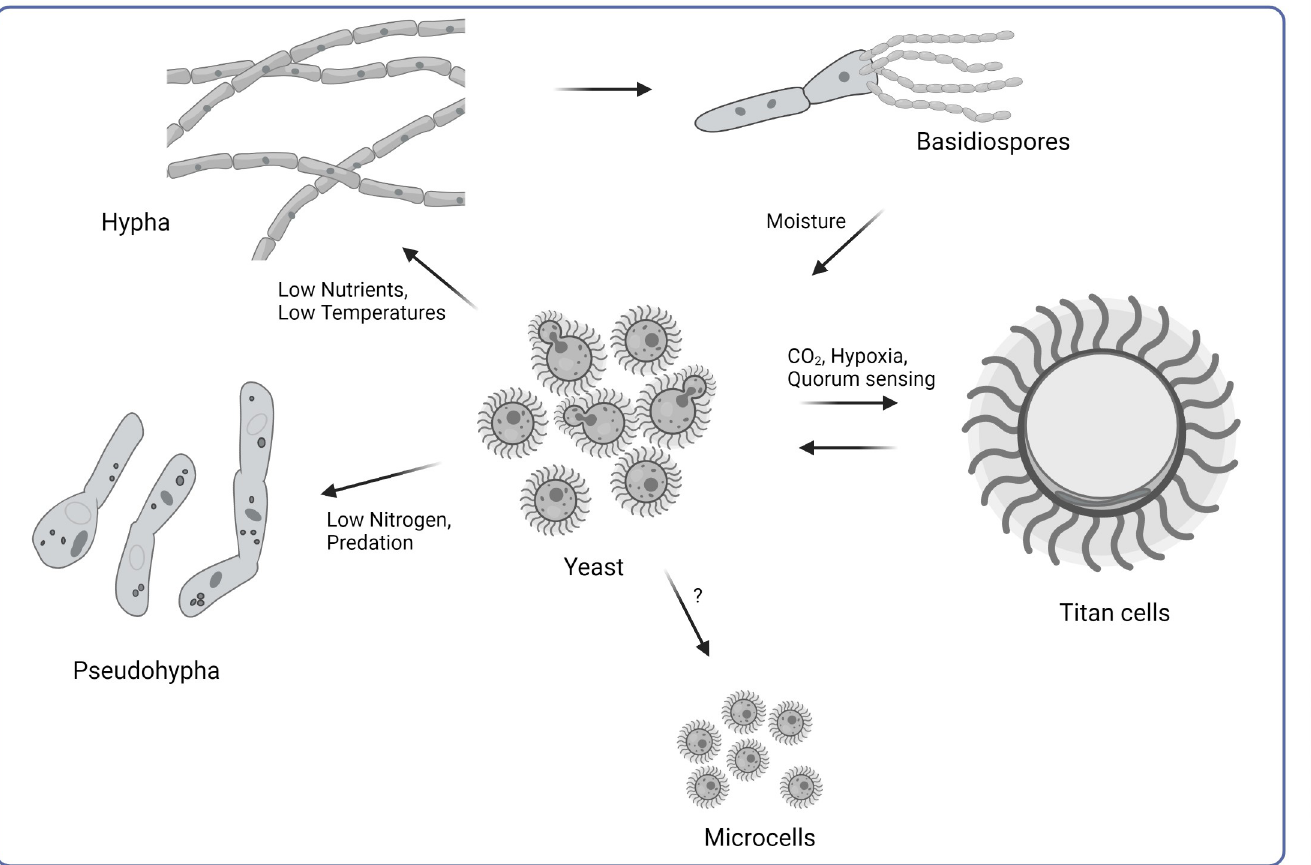
Fig 1. Illustration AU : Pleasecorrectthespellingoftheword } Nutriens } to } Nutrients } andprovidearevisedFig 1 file : of the morphological changes of Cryptococcus neoformans cells. C . neoformans adapts to the surrounding environment by adjusting the cell morphology in response to various stimuli, therefore increasing the chance of survival in the natural environment or improving the virulence within the host.